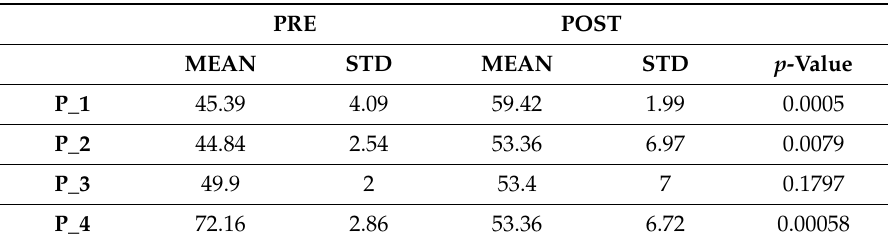
Table 5. Mean T 1 (cid:37) evaluation before and after the